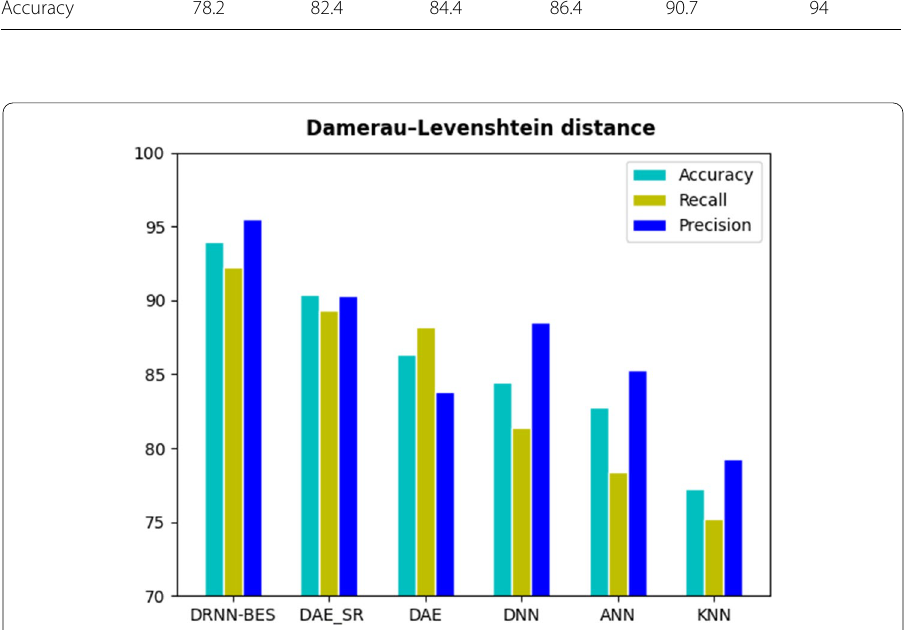
Fig. 4 Performance analysis based on Damerau–Levenshtein